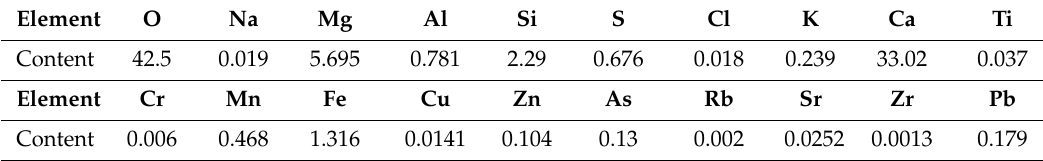
Figure 1. Tail sand particle size distribution curve. Table 1. Tailings of the main chemical elements (mass concentration).